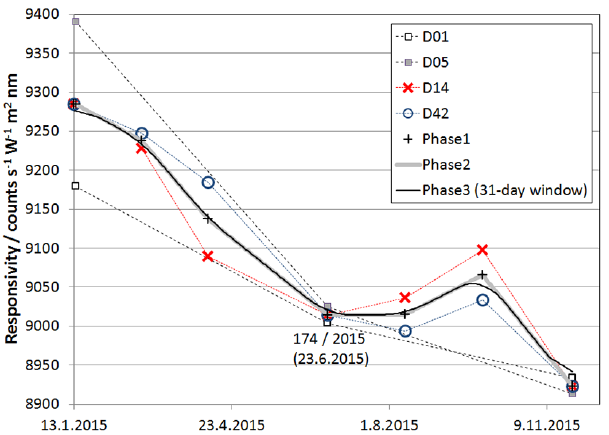
Figure 8. Demonstration of the phases in the determination of the final responsivity of type Level2 used for post-processing of solar spectral UV irradiance measured by Brewer #107 spectrophotome- ter. The dashed lines are plotted to guide the